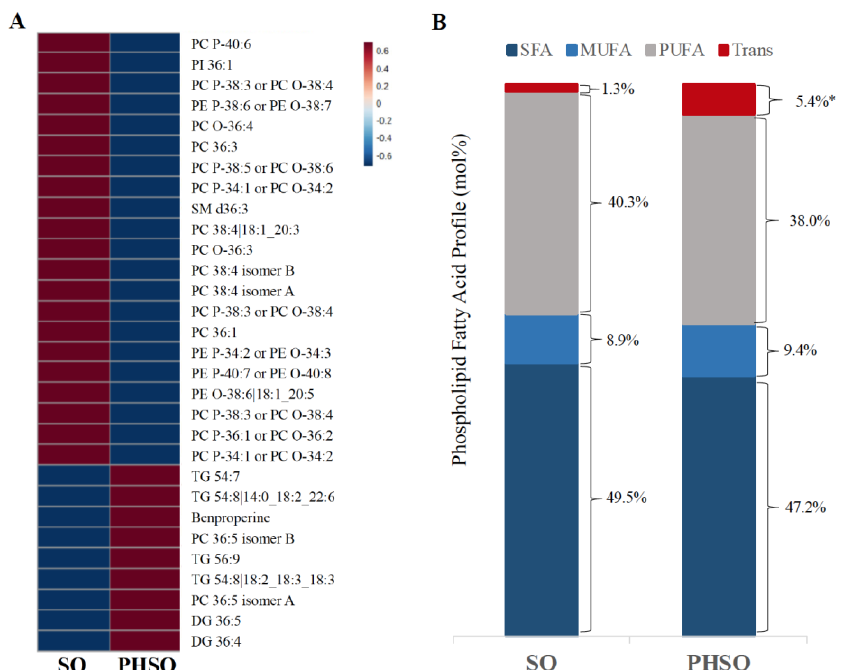
Figure 1. Plasma metabolite ( A ) and phospholipid fatty acid ( B ) Profiles after participants consumed the soybean oil (SO) and partially-hydrogenated soybean oil (PHSO) enriched diets. *, p < 0.01.